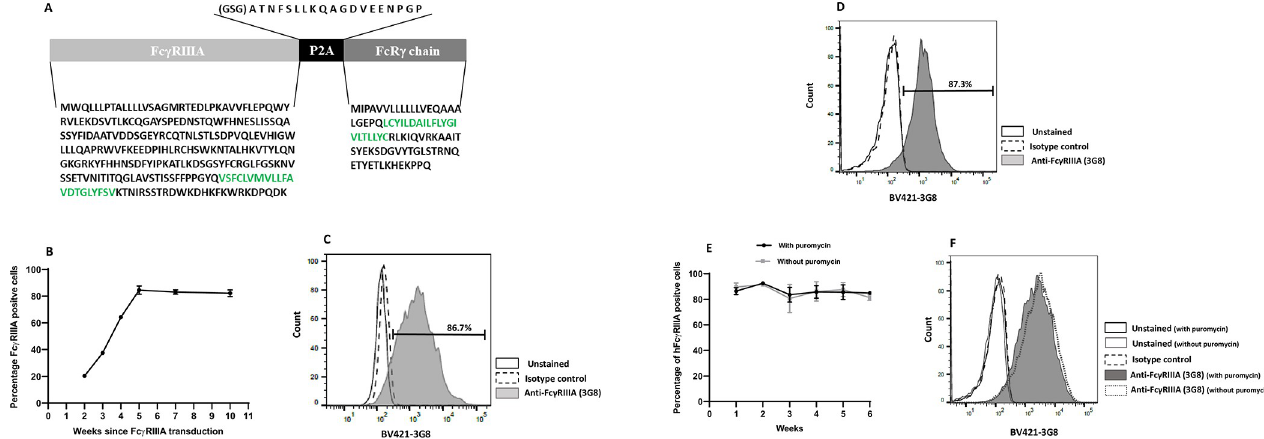
Fig 1. Generation of transgenic THP-1 cells expressing the low affinity Fc γ RIIIA and the FcR γ chain (THP-1-CD16A cells). (A) Amino acid sequence of the Fc γ RIIIA-FcR γ chain transgene inserted by lentiviral transduction to obtain long-term expression of Fc γ RIIIA. The amino acids highlighted in green represent the transmembrane region. The sequence encoding peptide 2A (P2A) was used to generate a bicistronic vector driving equimolar expression of both proteins from the same mRNA. (GSG) residues were added to the 5’-end of P2A to improve cleavage efficiency. The lentiviral system also included a puromycin-resistance gene for the selection of transduced cells. (B) Puromycin selection of lentiviral transduced THP-1 cells. THP-1 cells, following Fc γ RIIIA-FcR γ chain lentiviral transduction, were cultured in the presence of puromycin (5 μ g/mL) to select against non-transduced THP-1 cells. Fc γ RIIIA expression was assessed by flow cytometry on weeks 2, 3, 4, 5, 7 and 10 after transduction. Fc γ RIIIA expression was detected using a BV421-conjugated mouse anti-human Fc γ RIIIA (clone 3G8) antibody. Data are presented as the mean ± the standard deviation from two independent determinations. (C) The histogram represents one of the measurements performed on week 5. (D) The histogram represents a measurement after 40 weeks of cell culture with different numbers of passages in puromycin. (E) THP-1-CD16A cells were cultured with or without puromycin, and the expression of Fc γ RIIIA was evaluated using the BV421-conjugated mouse anti-human Fc γ RIIIA (clone 3G8) antibody for 6 weeks. Data are presented as the mean ± the standard deviation from two independent experiments. (F) The histogram represents one of the measurements performed on week 6. Flow cytometry was performed using a BD LSRFortessa X-20. Data analysis was performed using FlowJo